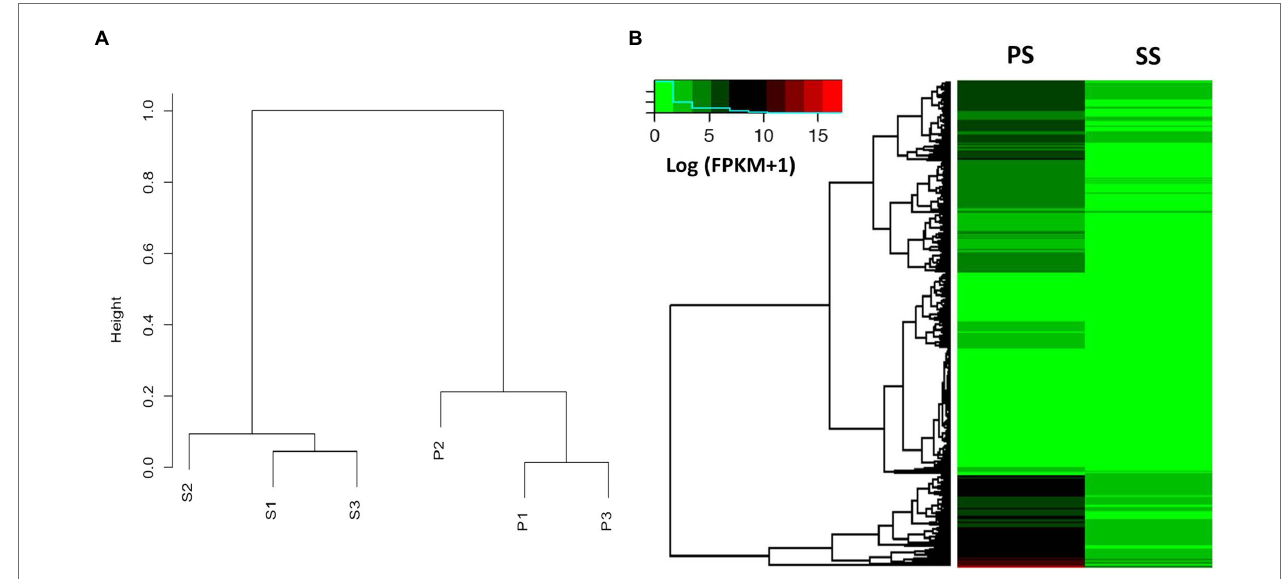
FIGURE 5 | Dendrogram and heat map analysis between PS and SS of anthracnose caused by C. gloeosporioides on apples. (A) Dendrogram showing the expression values (FPKM) of each gene calculated by the Pearson correlation coefficient as a distance between the two samples and the distance between the replicates within each sample that is much closer compared to other samples. The variation within samples is much smaller than the variation between samples. (B) Genome-wide analysis of differentially expressed genes (DEGs) of PS and SS from apple anthracnose, using heat map analysis based on the Kyoto Encyclopedia of Genes and Genomes (KEGG) pathway mapper. Relative expression profiles of PS genes compared to those of the SS genes. Hierarchical clustering of genes based on the expression ratio ranks between PS and SS. As a result, the 3,353 genes were grouped into four clusters. The fold change is represented by color (see the color bar